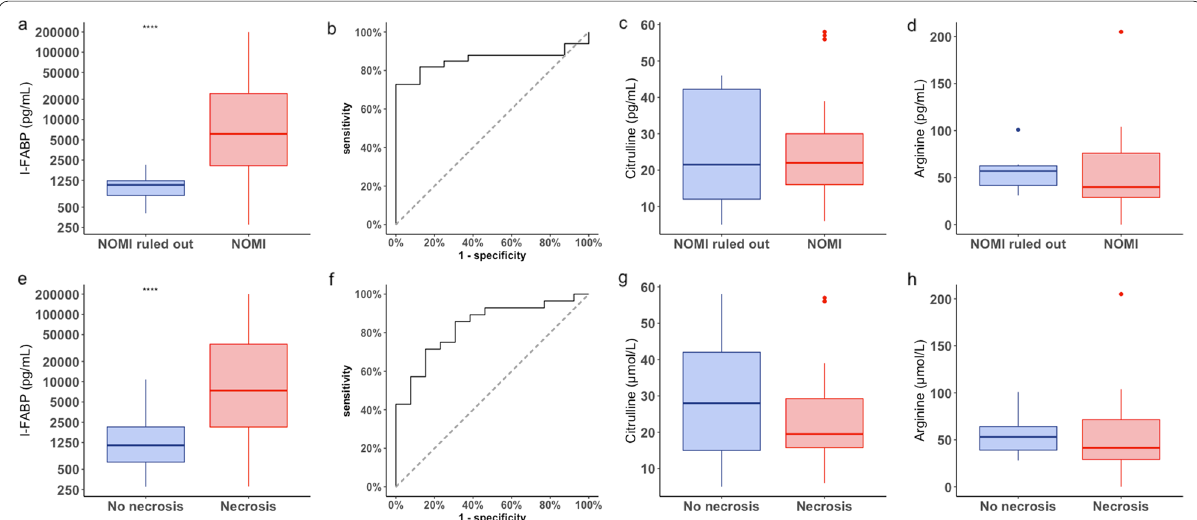
Fig. 2 Boxplot ( a ) and ROC curve ( b ) of plasma I‑FABP, boxplot of plasma citrulline ( c ), plasma arginine ( d ) for intestinal necrosis diagnosis. Box plot ( e ) and ROC curve ( f ) of plasma I‑FABP, box plot of plasma citrulline ( g ) and plasma arginine ( h ) for NOMI